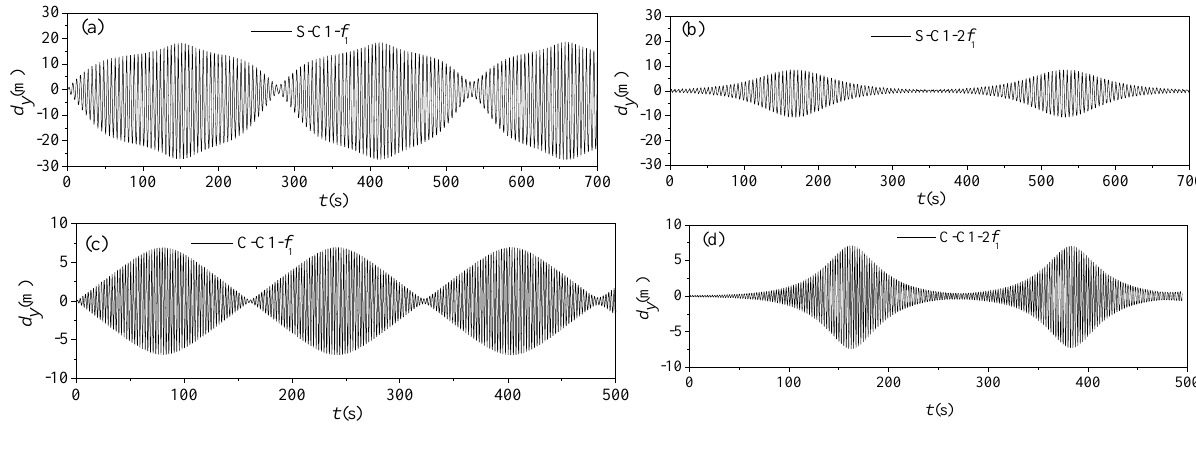
Figure 12. Parametric vibration response of stay cable C1 (undamped): ( a ) steel cable under excitation frequency f = f ; ( b ) steel cable under excitation frequency f = 2 f 1 ( c ) CFRP cable under excitation frequency f = f ; ( d ) CFRP cable under excitation 1 frequency f = 2 f . 1